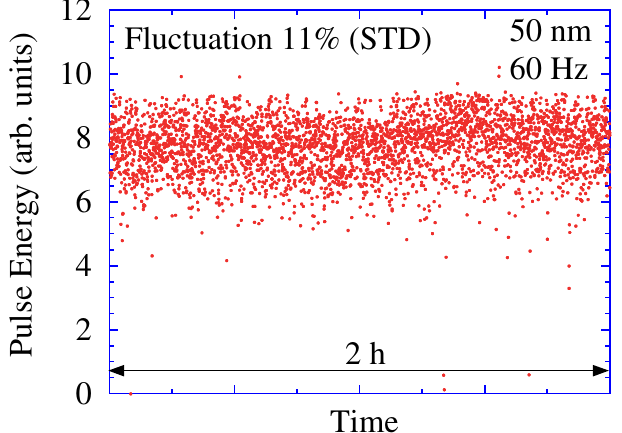
FIG. 11. (Color) Shot-by-shot fluctuation of the SASE pulse energy over a 2-h period at the wavelength of 50 nm with the repetition rate of 60 Hz.